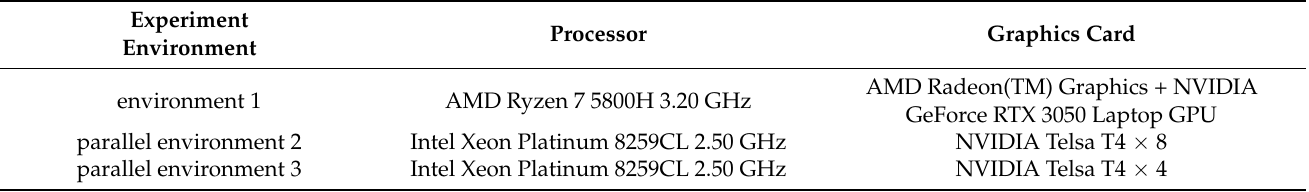
Table 2. Details of Experimental Environment.